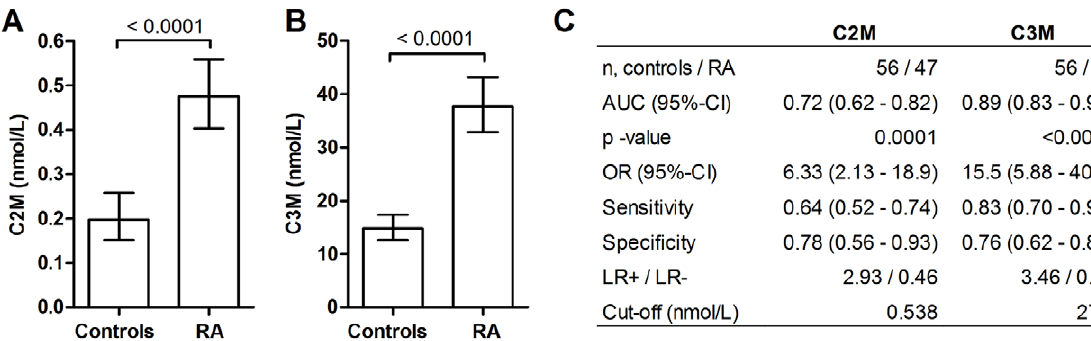
Figure 1. The level of the cartilage degradation and connective tissue inflammation in RA patients (n=47) and healthy controls (n=56). A) Cartilage degradation measured by C2M in serum. B) Connective tissue degradation measured by C3M in serum. C) The diagnostic utility depicted as area under the curve (AUC), odds ratio (OR), sensitivity, specificity and likelihood ratio (LR). Cut-off values were set as 1 SD above the mean of the healthy controls. Comparison of RA patients and controls was performed on log transformed data with student’s t-test. Results are shown as geometric mean with 95% CI. Diagnostic utility was calculated by a contingency table applying Fisher’s exact test. doi:10.1371/journal.pone.0054504.g001 with disease activity score (DAS), health assessment questionnaire (HAQ), erythrocyte sedimentation rate (ESR), C-reactive protein (CRP), swollen (SJC) and tender joint count (TJC). There was no correlation (table 3) between serum C2M and C3M.